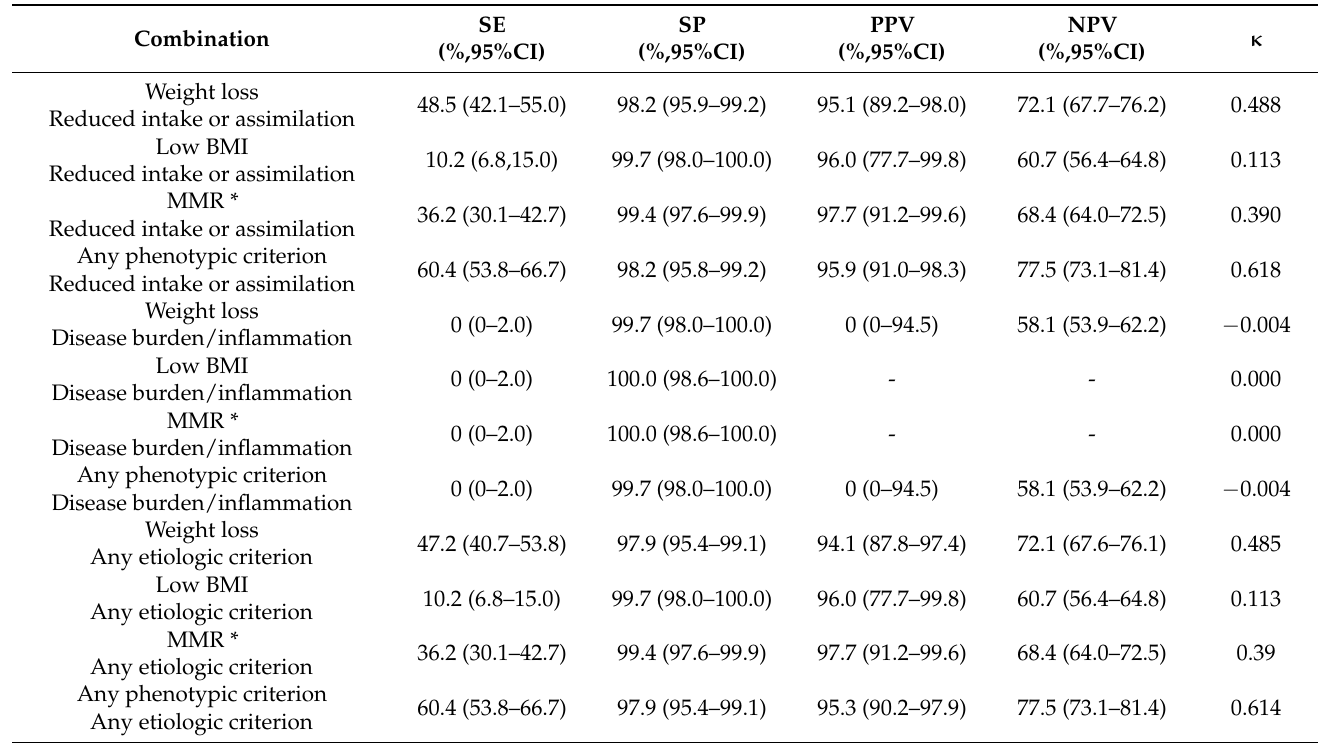
Table A1. SE, SP, PPV, and NPV of GLIM using different combinations of phenotypic criteria and etiologic criteria in diagnosing malnutrition compared with